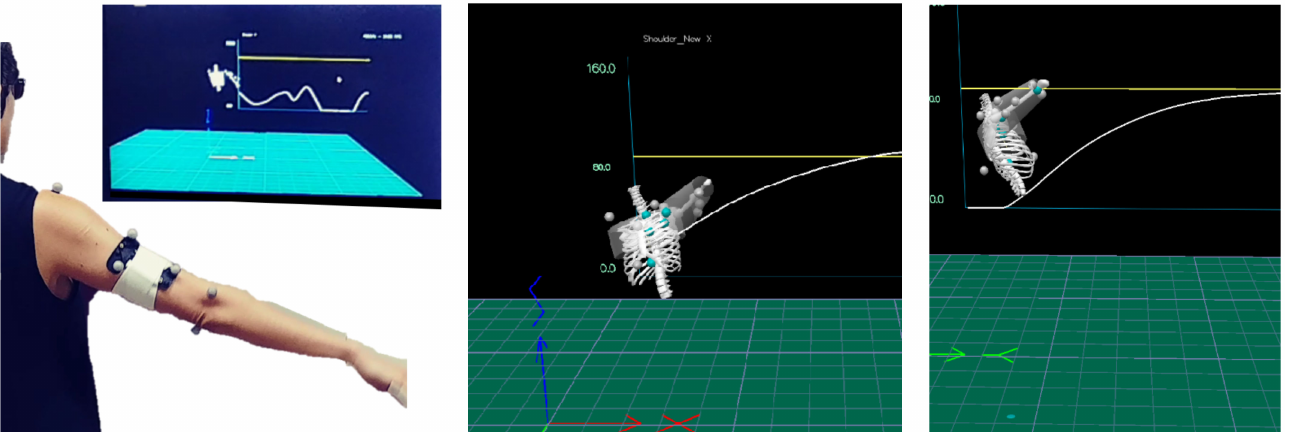
Figure 1. The subject ( left frame ) standing in front of the virtual presentation during shoulder abduction ( middle frame ) and flexion ( right frame ), as presented to the subject. The horizontal yellow line marks the target of 90 ◦ . The white line is the shoulder angle, presented in real-time. In these pictures, a healthy volunteer demonstrates a full range of